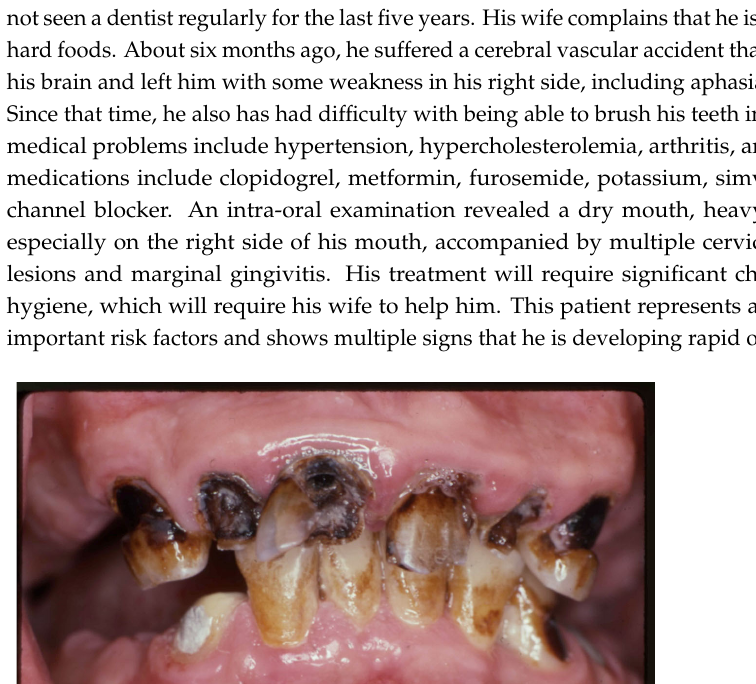
Figure 4. A 65-year-old male is brought for treatment by a social worker as he is in pain. The patient is currently being treated for alcoholism and drug misuse in a hospital se tt ing. He has no family members with whom he is in contact and has been homeless for the last fi ve years. His health history